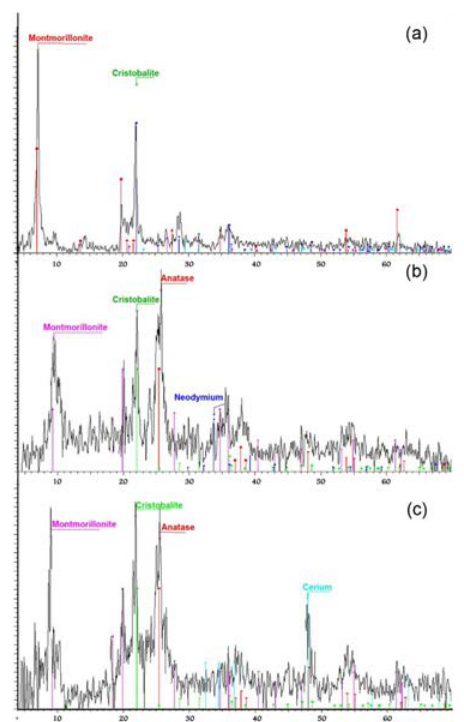
Fig. 3. The XRD pattern of (a) bentonite, (b) Nd –TiO2/ bentonite and (c)